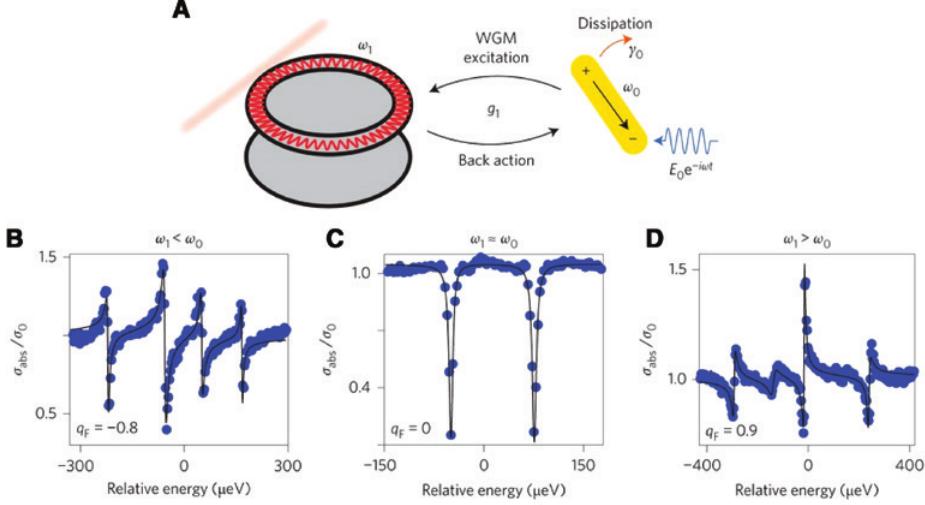
Figure 16: Pictorial description of coherent interactions between WGMs and localised surface plasmons. (A) There is pumping of the localised surface plasmon via a time-varying field E between the WGM and localised surface plasmon is characterised by g resonance (black line) and experimental spectrum (blue dots) for ω tive interference at lower energies. (C) Fano resonance and experimental spectrum for ω resonance and experimental spectrum for ω energies. Reprinted from [113].